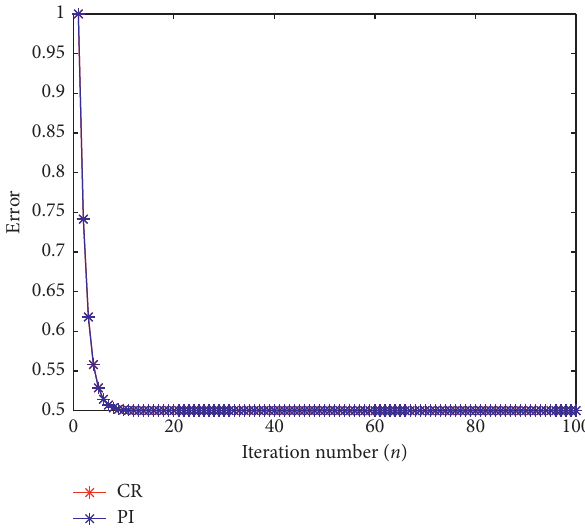
Figure 2: Errors versus iteration numbers ( n ): Example 1 (Case